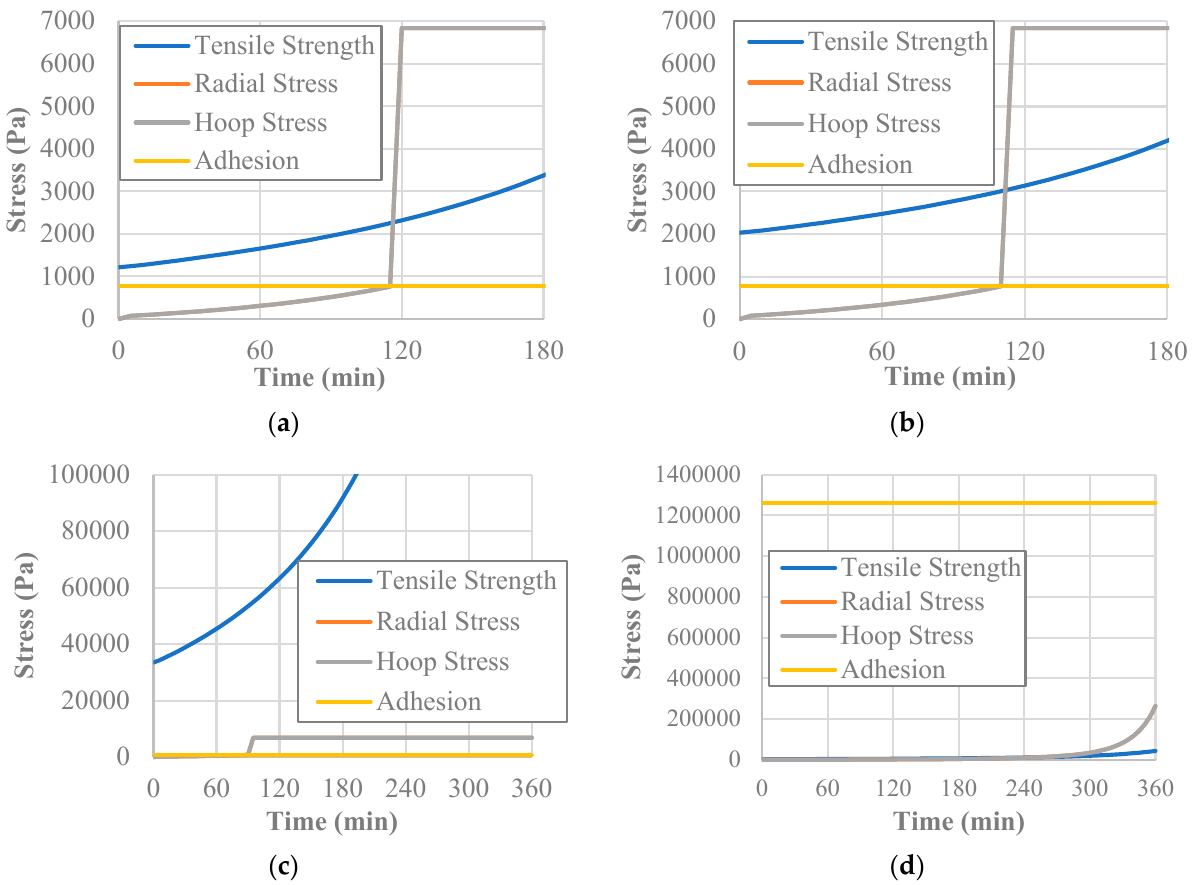
Figure 12. Stress progression at the center of the soil surface over time for the ( a ) untreated; ( b ) 0.5% fiber-treated; ( c ) 2% fiber-treated; and ( d ) xantham-gum-treated